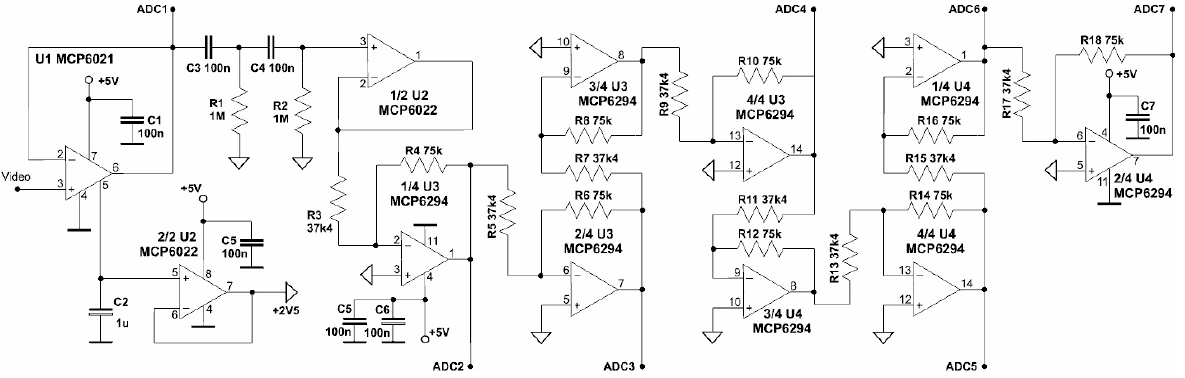
Figure 13. The tested video pulse conditioning circuit.